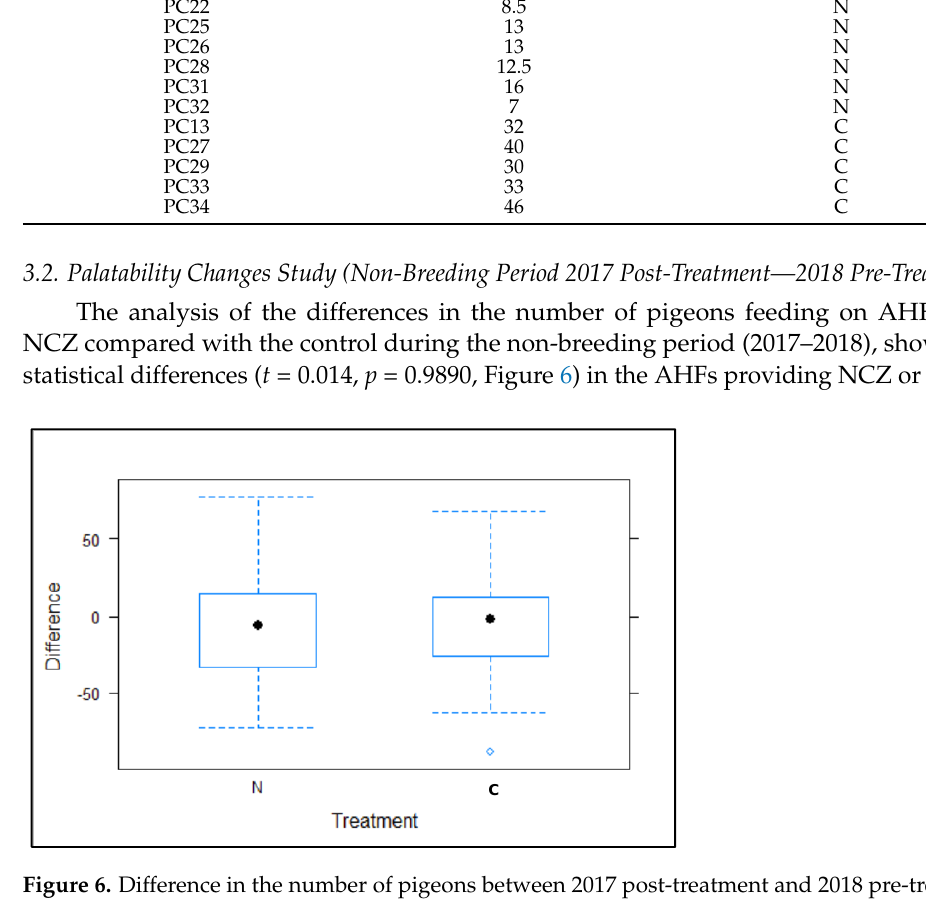
Figure 7. Population trend of the treated pigeon colonies during pre-treatment (PRE-T) and post- treatment (POST-T) periods of the study. Vertical lines indicate standard error; treatment periods with different superscripts (a, b, c) are different ( p < 0.05).